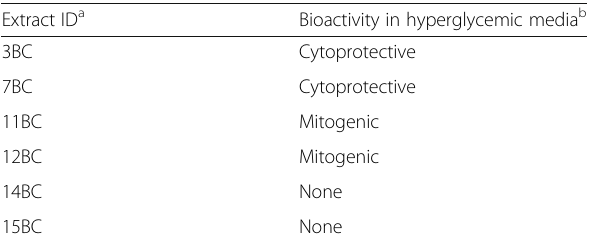
Table 3 Bioactivity of Picea mariana cone extracts in PC12-AC grown in hyperglycemic media